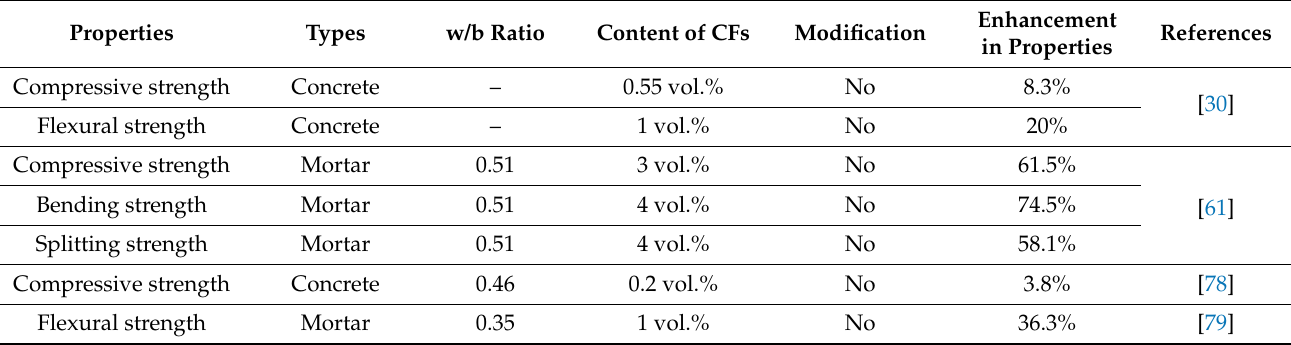
Table 1. Mechanical and durability properties of unmodified CFRC.